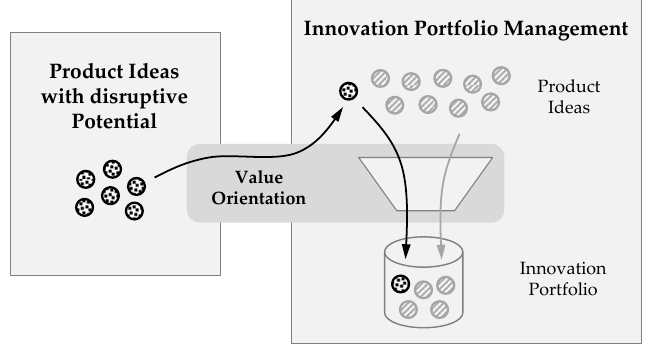
Figure 1. Managing DI by value-oriented IPM, based on [6].